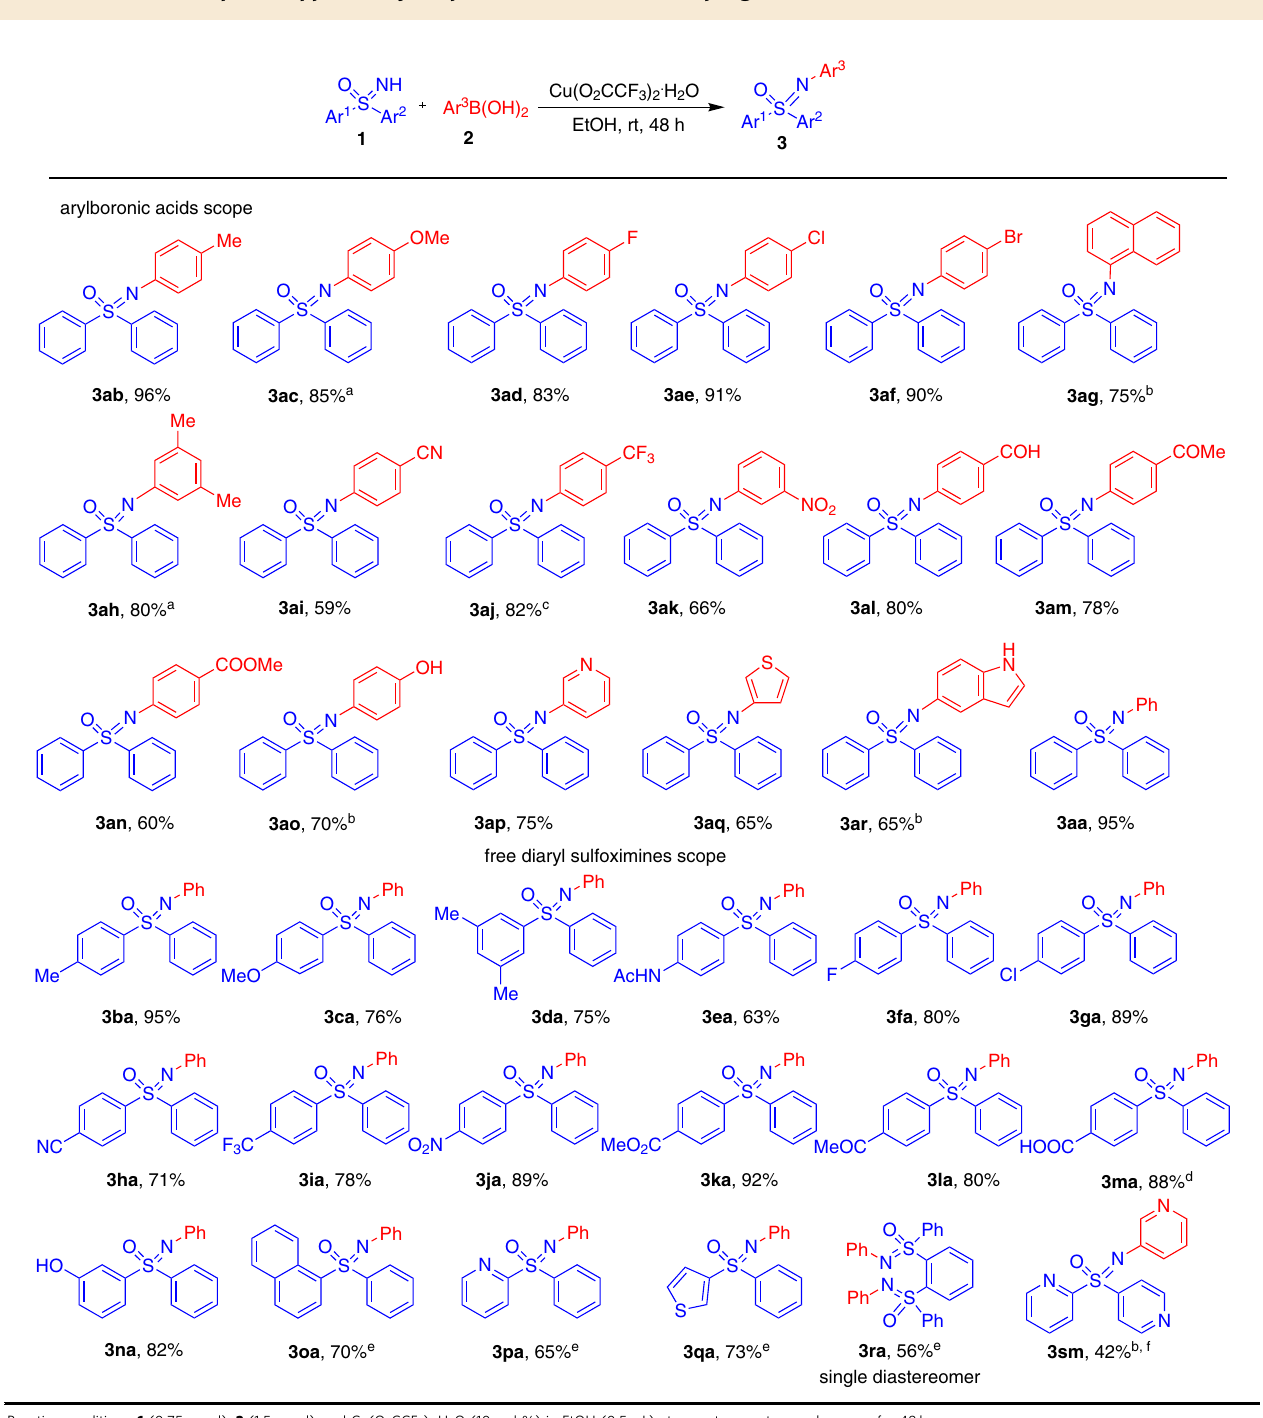
Table 2 Substrate scope of copper-catalyzed photoredox Chan-Lam